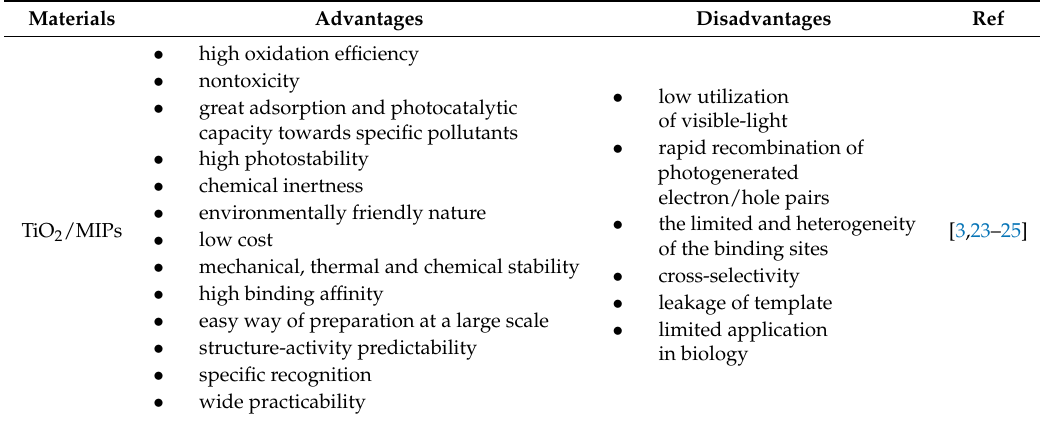
Table 1. Advantages and disadvantages of MIPs modified TiO 2 nanomaterials.